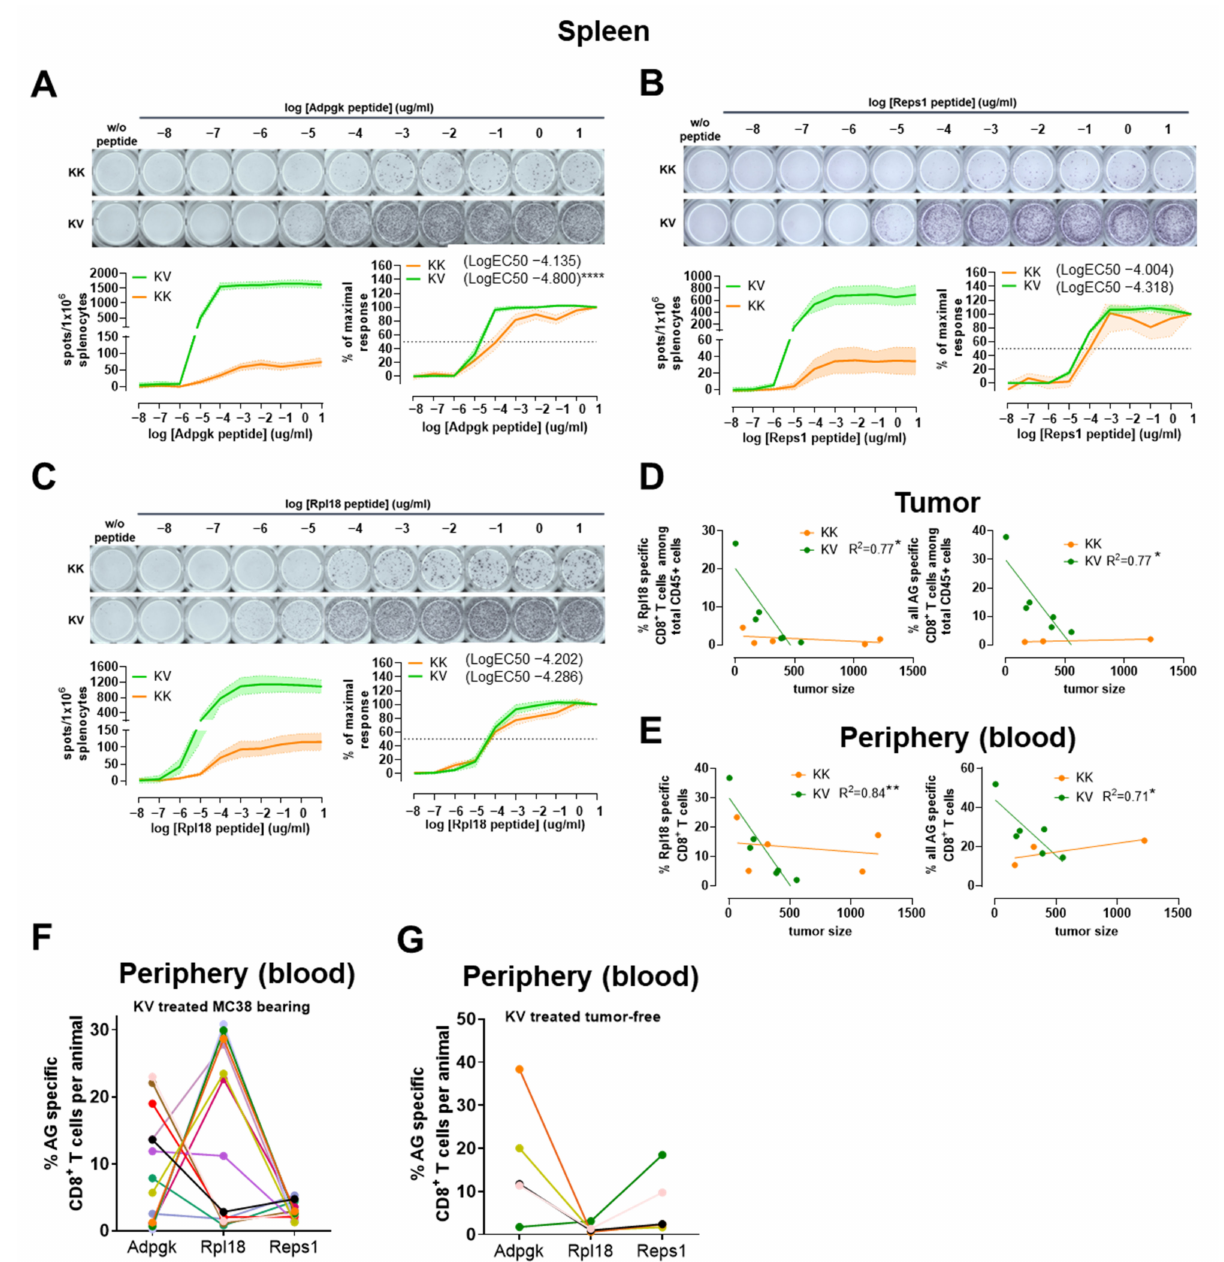
Figure 6. TCR avidity: the correlation of antigen-specific CD8+ T cells to tumor size and antigen competition in MC-38 tumor-bearing or non-tumor-bearing C57BL/6 mice. ( A ) Representative IFN- γ spot images of KK or KV derived splenocytes harvested on day 18 post-MC-38 tumor implantation and incubated for 24 h with varying concentrations of Adpgk peptide respectively (top). Dose–response curve of IFN- γ spots per 106 splenocytes incubated with log-fold dilutions of Adpgk peptide (left). TCR avidity by IFN- γ spots (% to maximal response) determined by differences in LogEC50 (right). ( B ) Representative IFN- γ spot images of KK or KV derived splenocytes harvested on day 18 post-MC-38 tumor implantation and incubated for 24 h with varying concentrations of Reps1 peptide, respectively (top). Dose–response curve of IFN- γ spots per 106 splenocytes incubated with log-fold dilutions of Reps1 peptide (left). TCR avidity by IFN- γ spots (% to maximal response) determined by differences in LogEC50 (right). ( C ) Representative IFN- γ spot images of KK or KV derived splenocytes harvested on day 18 post-MC-38 tumor implantation and incubated for 24 h with varying concentrations of Rpl18 peptide, respectively (top). Dose–response curve of IFN- γ spots per 106 splenocytes incubated with log-fold dilutions of Rpl18 peptide (left). TCR avidity by IFN- γ spots (% to maximal response) determined by differences